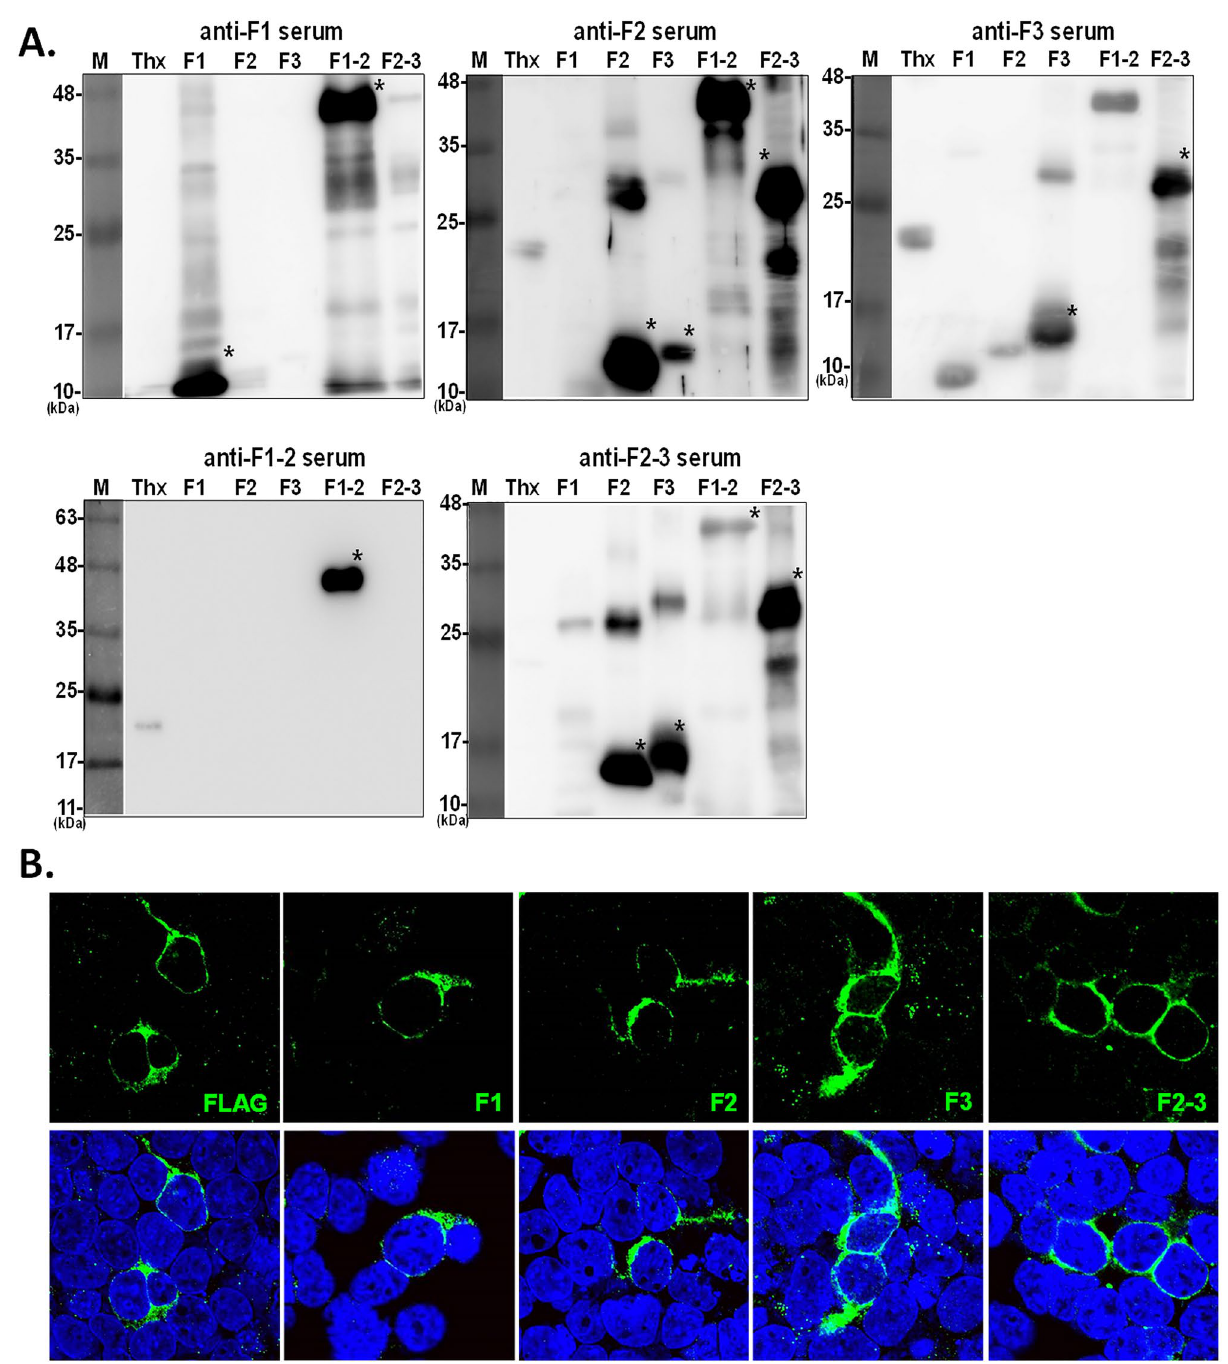
Figure 3. Verification of the specificity of anti-serum samples from mice immunized with various recombinant gB proteins. ( A ) Five antigenic fragments of gB protein and the fusion tag protein thioredoxin (Thx) were reacted with serum samples collected from mice immunized with F1, F2, F3, F1–2, and F2–3, as labeled on the top of each blot. The partial gB proteins specifically recognized by the mouse sera are indicated with asterisks. ( B ) Human 293 cells transiently expressing the full-length gB protein fused with a FLAG tag were used to confirm the specificity of antiserum F1, F2, F3, and F2–3. FLAG served as a positive control antibody against the gB-FLAG fusion protein. By IFA, the green fluorescence located in the cytoplasm indicated positive staining of gB. The nucleus was shown in blue by DAPI